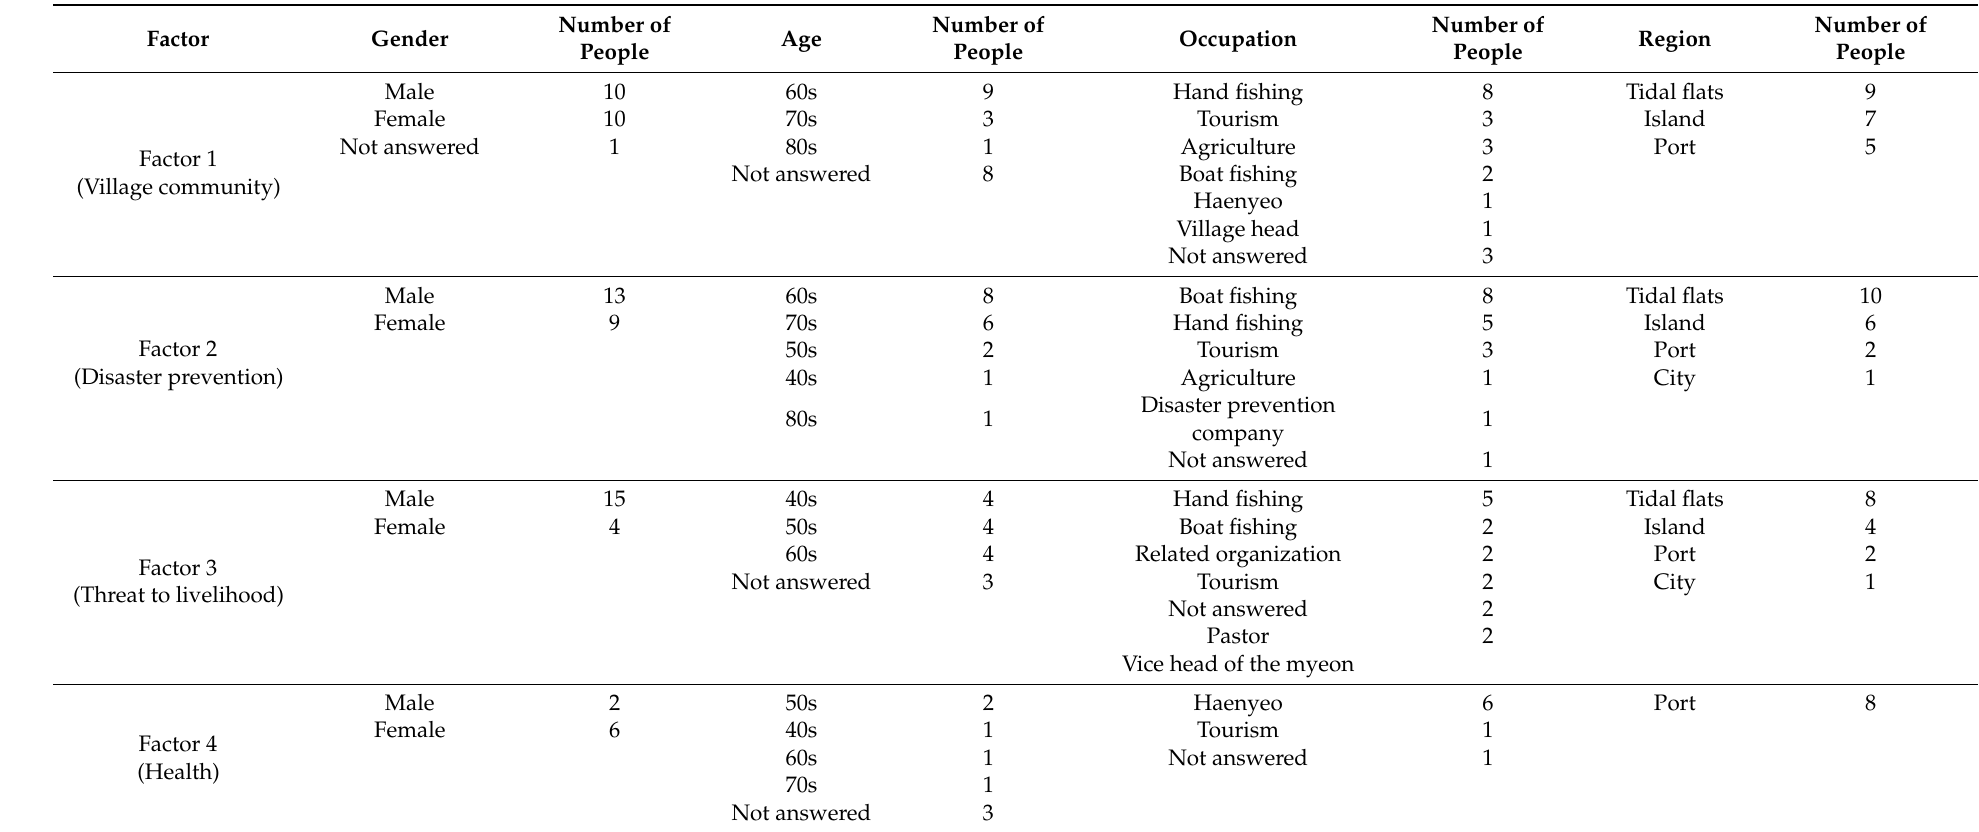
Table A2. Distribution of stakeholder by factors (raw data used for Figure